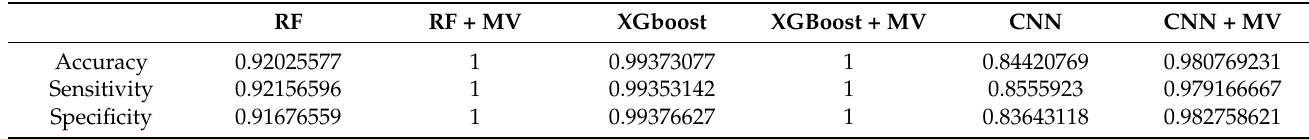
Figure 8. Classification performance, maximum tuberization phenological stage using two classes. Table 3. Comparison of classification performance of RF, XGBoost, and CNN alone and using MV for tubers differentiation phenological stage using two classes.